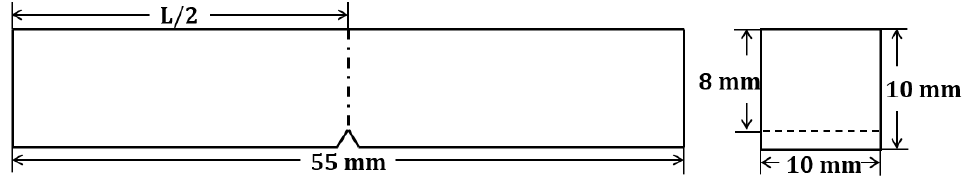
Figure 1. Charpy impact test specimen. Reprinted with permission from Ref. [18]. 2018, ASTM International.